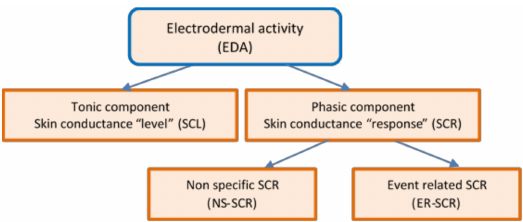
Figure 1. Diagram of the Electrodermal activity signal